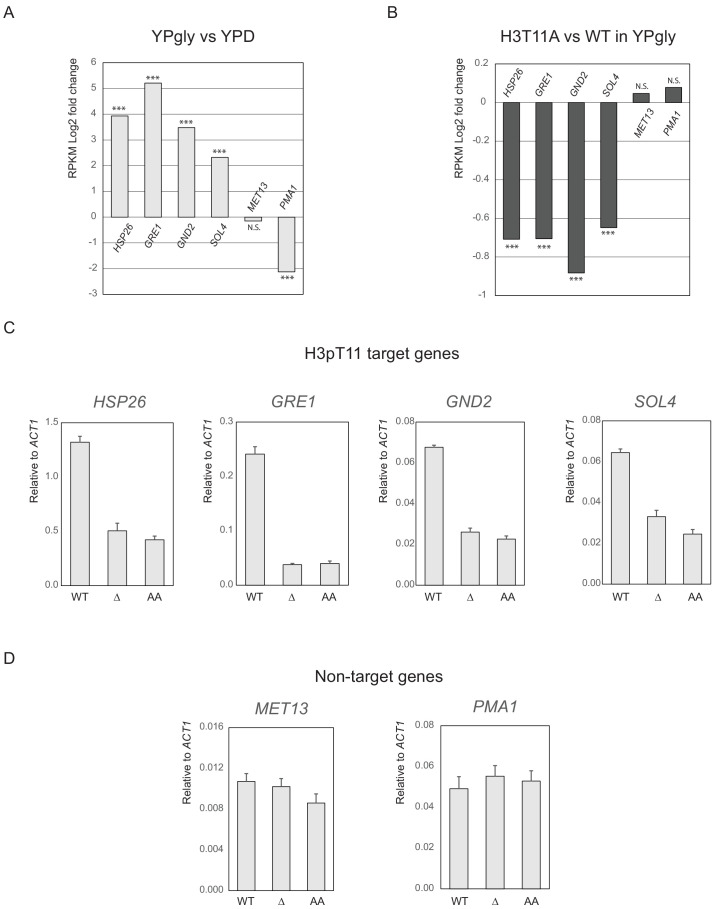
Tda1 S483/T484 phosphorylation is required for the transcription of H3pT11 target genes.(A and B) Log2 fold changes of RPKM (reads per kilobase of transcript, per million mapped reads) values in WT upon media shift from YPD to YPgly media (A) or in H3T11A mutant compared to WT in YPgly media (B), at four H3pT11 target genes (HSP26, GRE1, GND2, and SOL4) and two non-target genes (MET13 and PMA1). ***p-value<0.001; N.S.: not significant. The RPKM values and p-values were acquired from dataset GEO accession number GSE111217 and are listed in Figure 6—figure supplement 2—source data 1. (C and D) The relative gene expression ratio compared to ACT1 genes at four H3pT11 target genes (C) and two non-target genes (D) in WT, tda1Δ (Δ), and Tda1 S483A/T484A (AA) mutant. Error bars indicate STD of three biological replicates. Cycle threshold (Ct) values of Q-RT-PCR results are listed in Figure 6—figure supplement 2—source data 1.
Figure 6—figure supplement 2—source data 1.Raw data used for Figure 6—figure supplement 2.